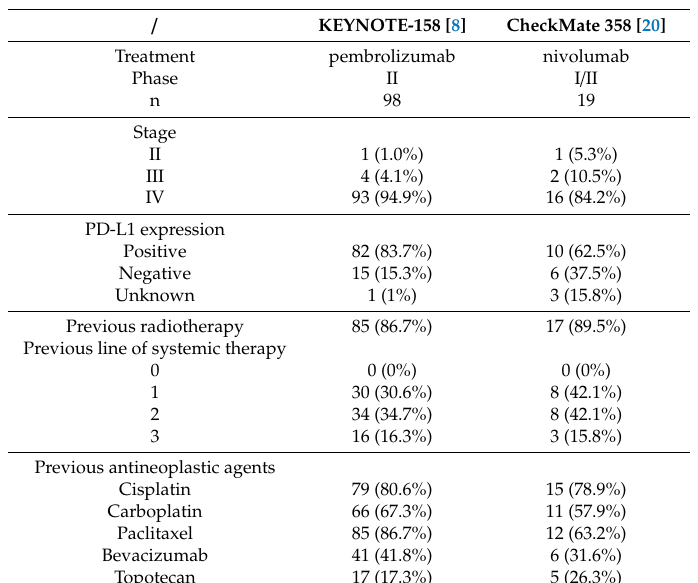
Table 1. Patient characteristics of KEYNOTE158 and CheckMate 358.